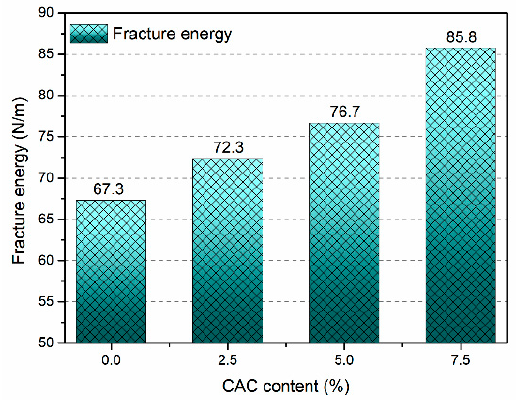
Figure 9. Fracture energy of FAGC with different CAC contents.